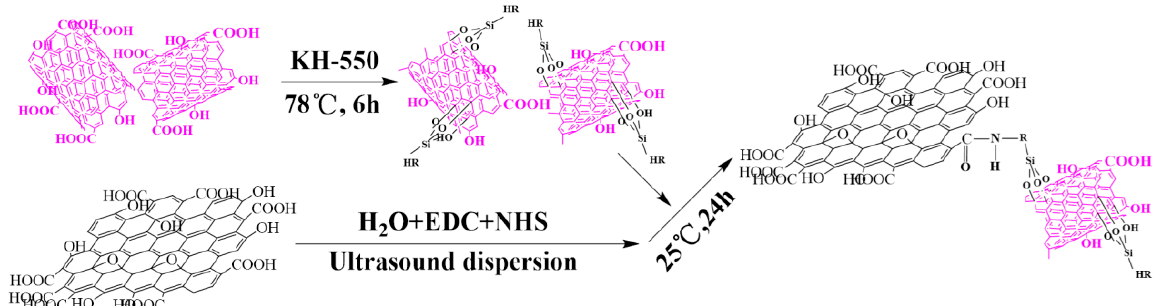
Figure 1. The reaction mechanism diagram.